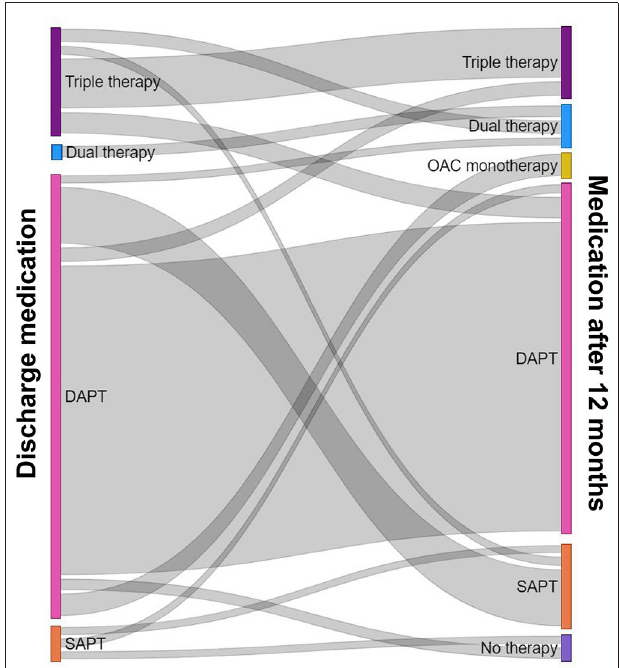
FIGURE 2 | Detailed information on the antithrombotic treatment at discharge and 12 months after PCI for AMI. PCI, percutaneous coronary intervention; AMI, acute myocardial infarction.